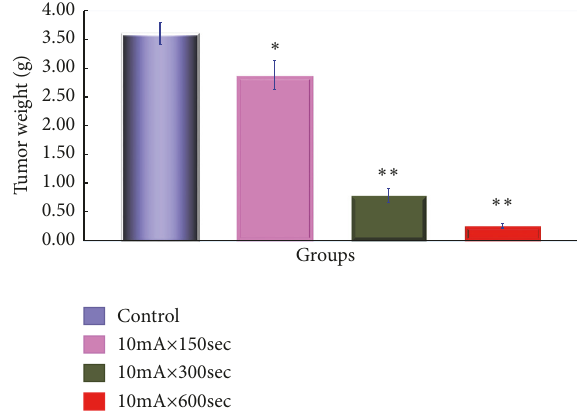
Figure 6: Tumor growth-inhibitory effect of ECT in Sarcoma-180 cells-bearing mice. Changes in the weight of the tumor. After tumor implantation, we measured the weight of the fifth week of the tumor of each group. The results represent ± S.D from 8 to 10 mice. ∗∗ Significantly different from the control group ( p < 0.01 ).